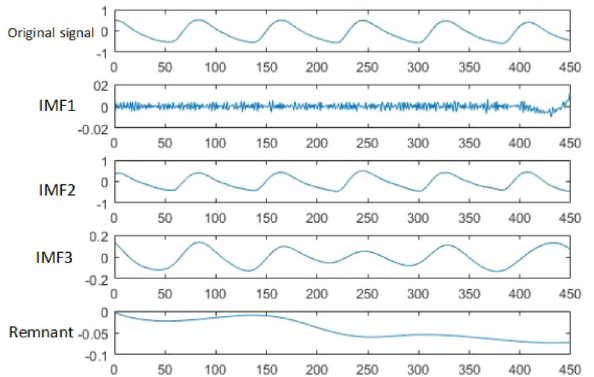
Figure 4. PPG signal EEMD decomposition.